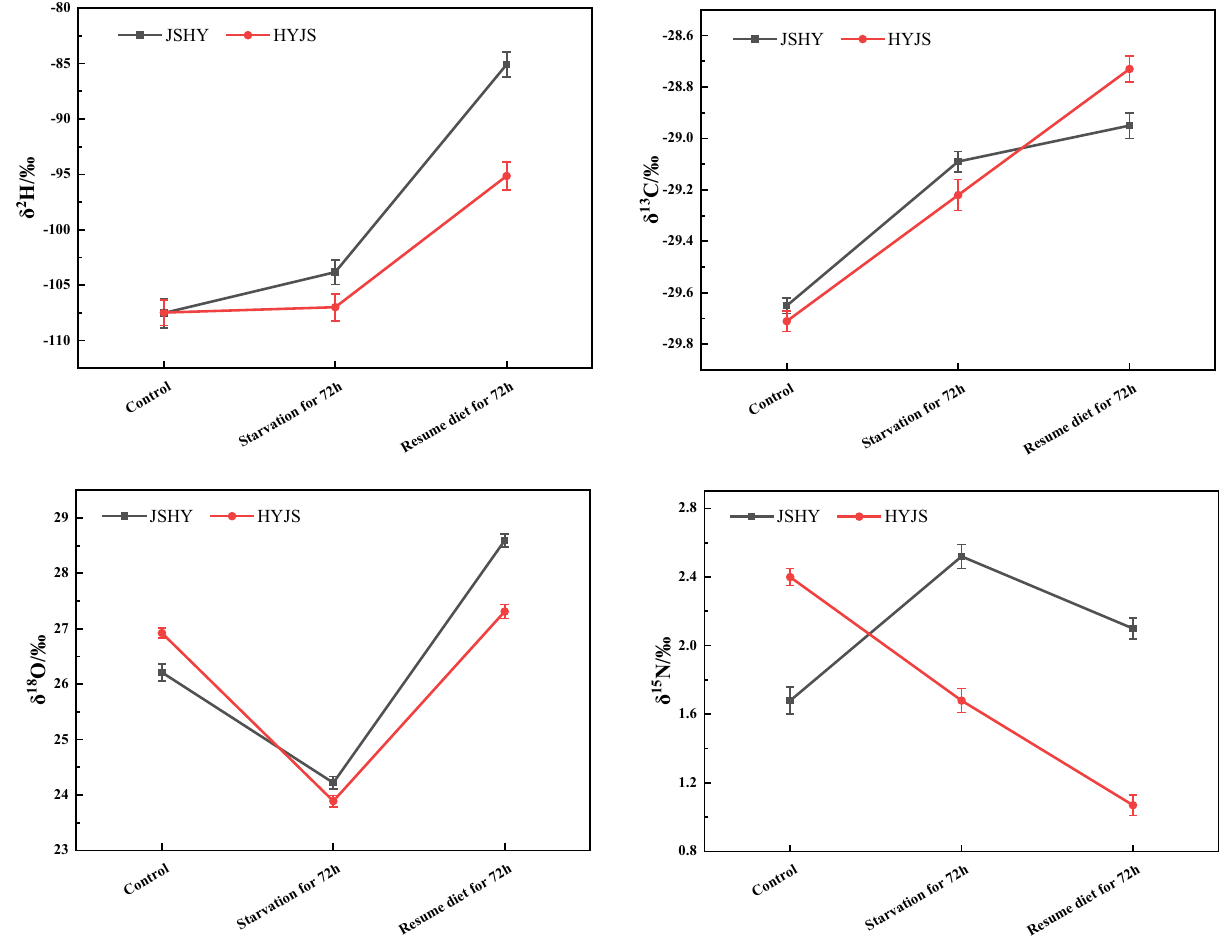
Figure 8. Changes of stable isotopes of hydrogen, oxygen, carbon, and nitrogen before and after starvation.